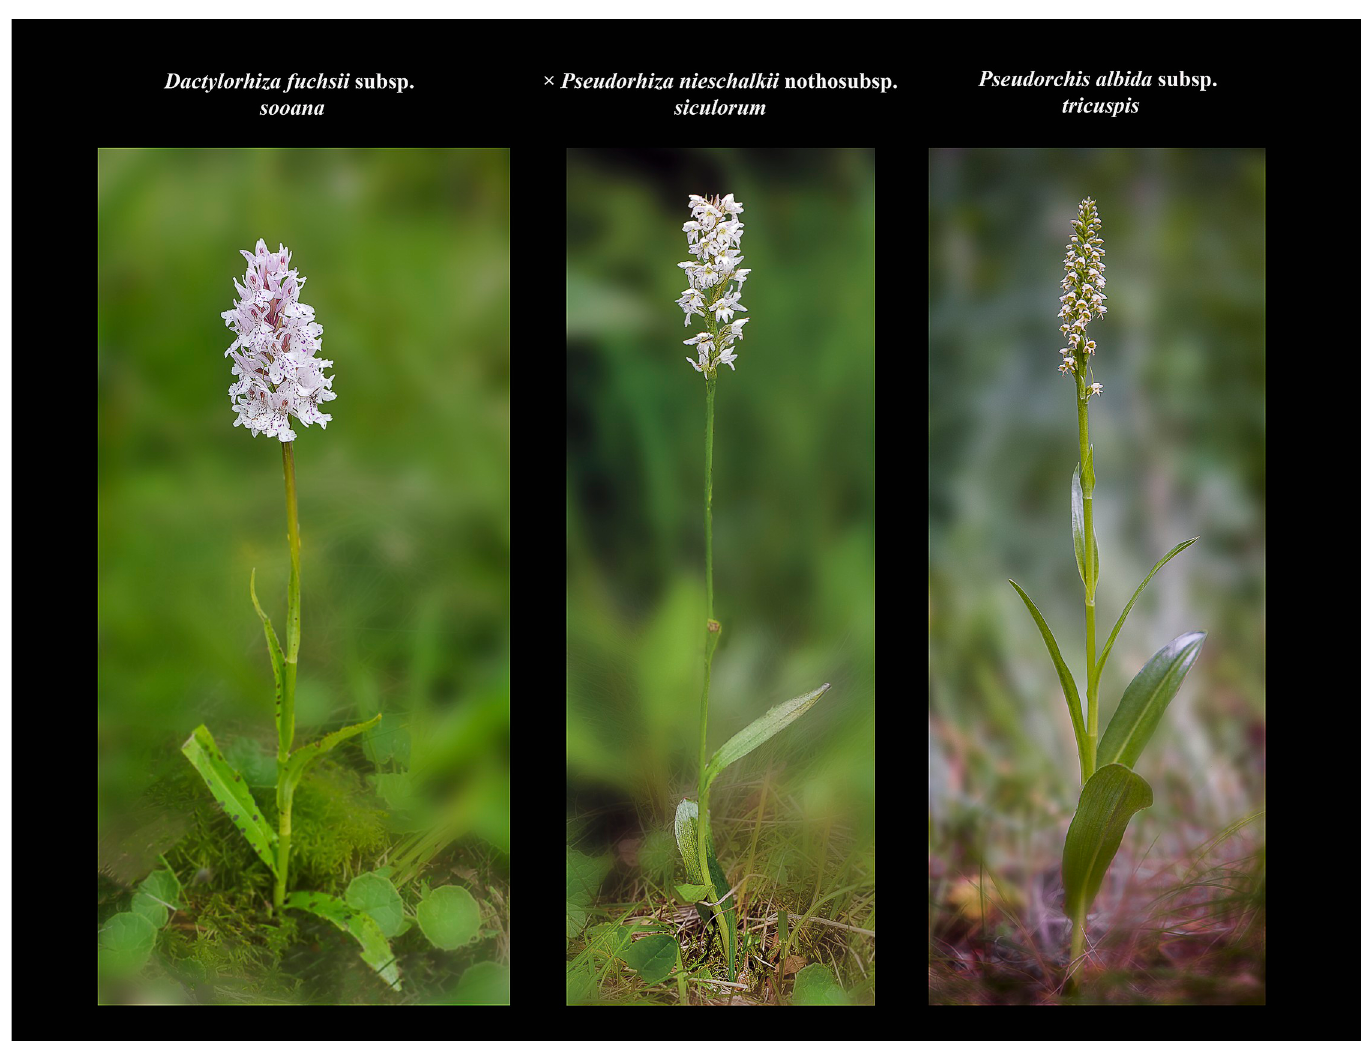
Fig 9. Morphological comparisons of × Pseudorhiza nieschalkii nothosubsp. siculorum and parents. The following three comparison diagrams show the intermediate characters of the hybrid’s habitus (Fig 9), inflorescence (Fig 10) and flowers (Fig 11), compared to those of its parents. The hybrids are almost as tall as the parents. The hybrid’s inflorescence is less floriferous and flat topped, resembling more that of D . fuchsii subsp. sooana parent. The flowers’ labellum is deeply three-lobed, very similar to P . albida subsp. tricuspis ’ labella. Figs 9–11 © 2020 N. Anghelescu originals.